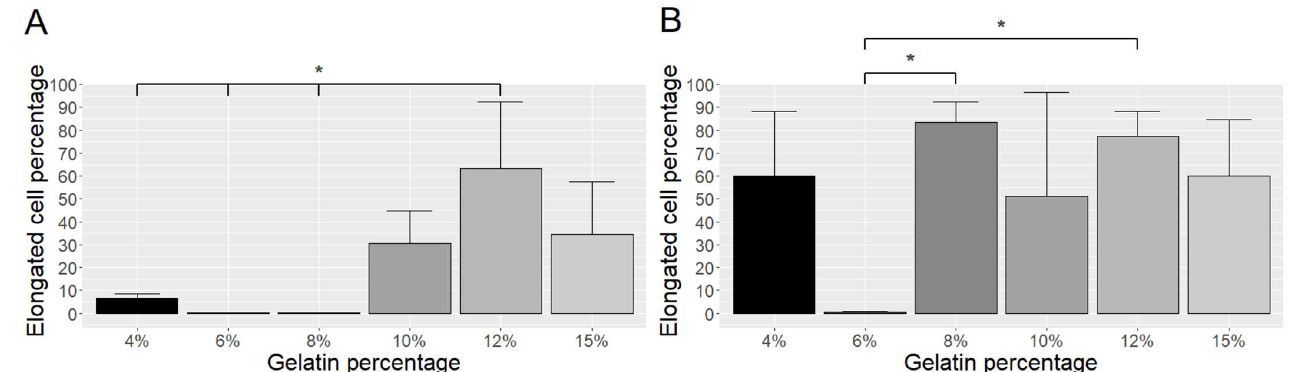
Figure 2. Differentiation of BC on gelatin of different concentrations after one day ( A ) and three days ( B ) of culture. The proportion of elongated cells was calculated by counting the cell numbers of non-elongated and elongated cells in three random images. * p ≤ 0.05